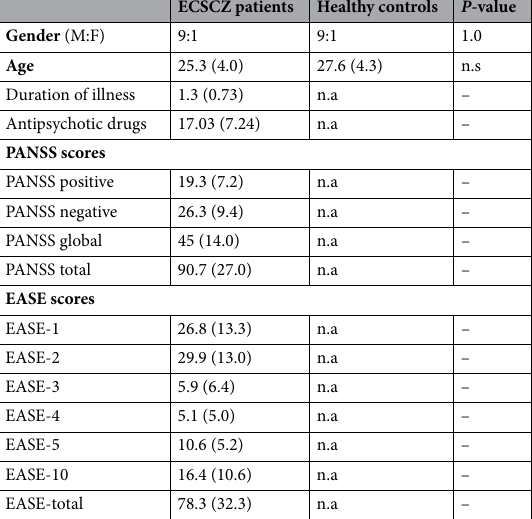
Table 1. Participants’ demographics and psychopathological evaluations. Mean values (standard deviation) are reported. Age and duration of illness are expressed in years. Dosage of antipsychotic drugs at the time of electroencephalographic (EEG) recording is expressed in olanzapine